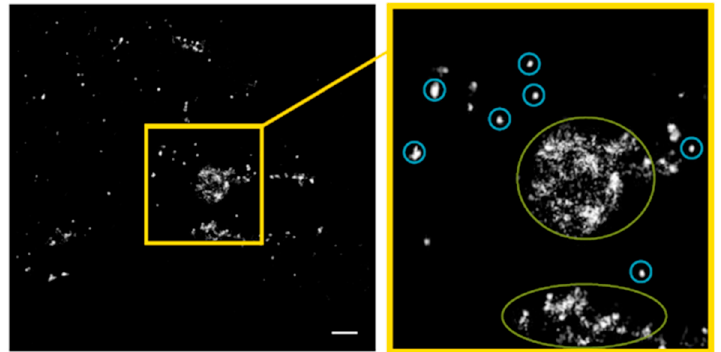
Figure 10. Pointillist image of Cx43 molecules in the accumulation regions at the contact zones of untreated BJ cells obtained from the coordinate matrices after SMLM. The clustered points (encircled in blue) represent points contributing to the small left peak at about 29 nm in Figure 8c. The dispersed points (encircled in green) represent points contributing to the right broad peak (>400 nm) of the curve in Figure 8c. Scale bar 1 µm.